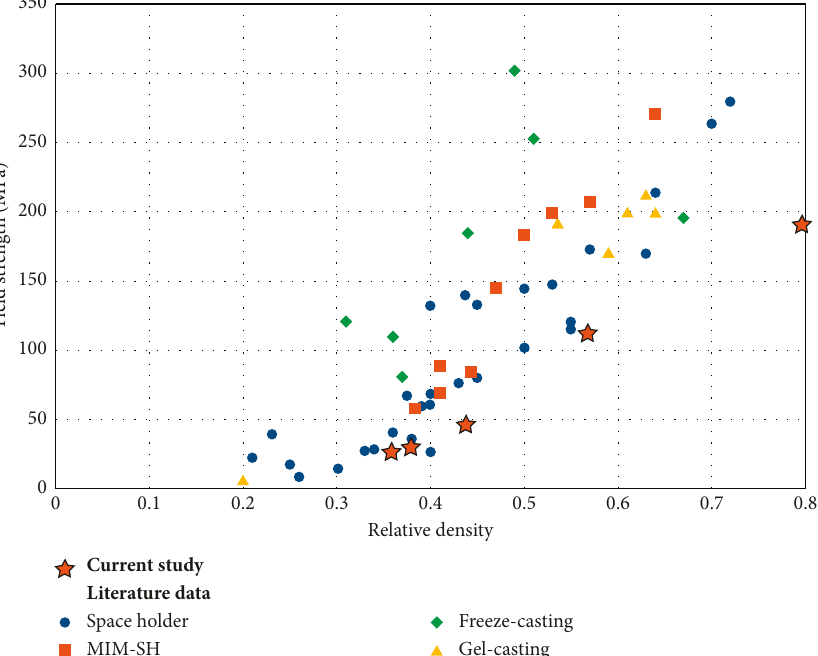
Figure 7: Comparison of yield strength between Ti foams processed by the current study and those reported in the literature for nonalloyed porous titanium with random structures. For ease of representation, data are grouped into the broad classes of methods, ignoring variations in how the technique is applied and pore size. Data are from [22,